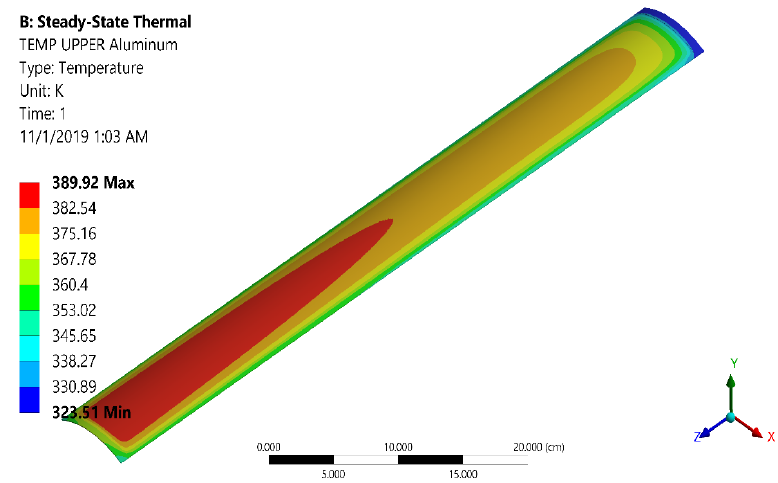
Figure 15. Temperature contours for the convex side of the fuel plate.